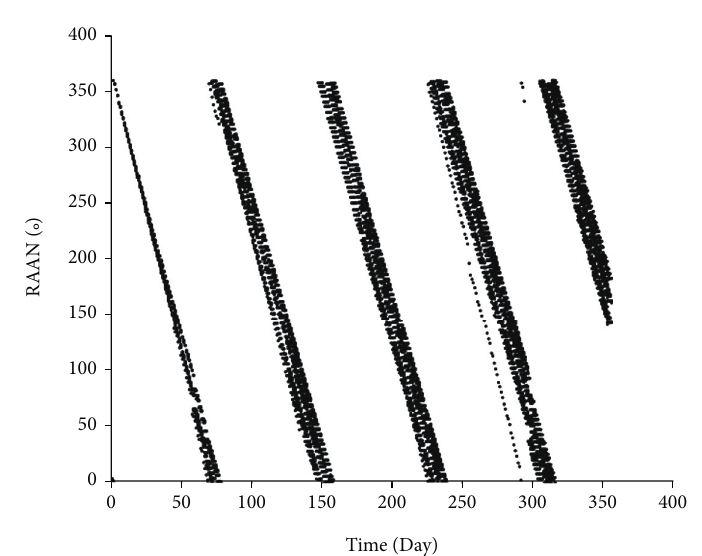
Figure 11: Initialization of